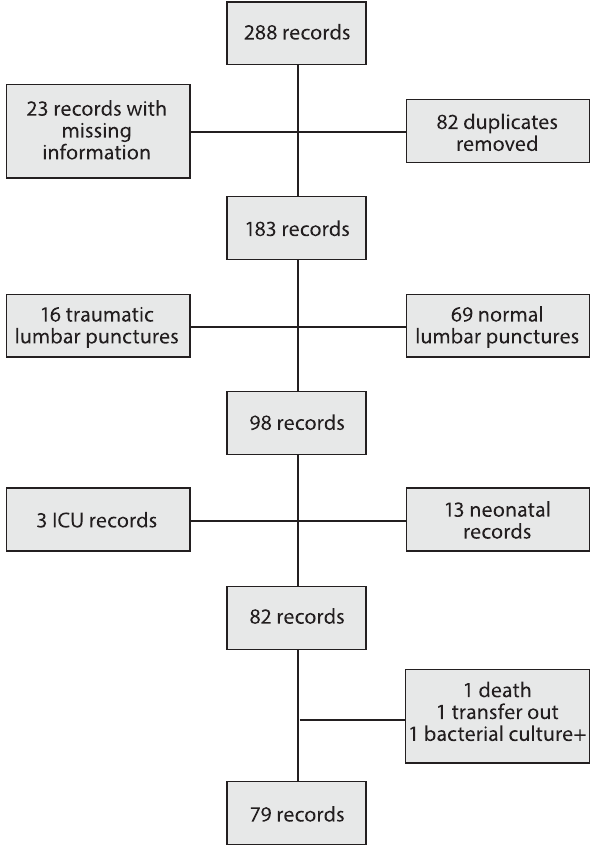
Figure 1: Flow diagram showing selection of specimens for inclusion in the